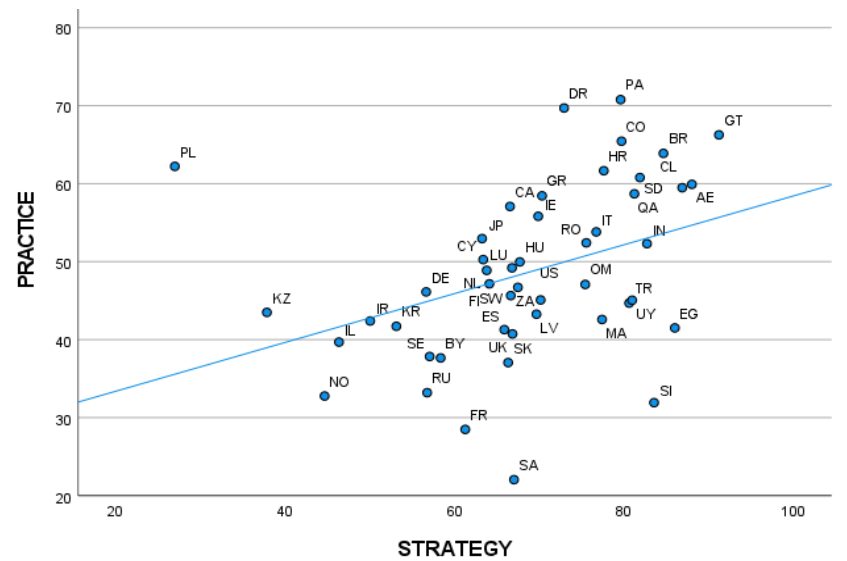
Figure 2. Countries plotted according to their aggregate strategy and their aggregate practice. Sources: Aggregate practice and aggregate strategy are based on national-level data, described in section on research method.